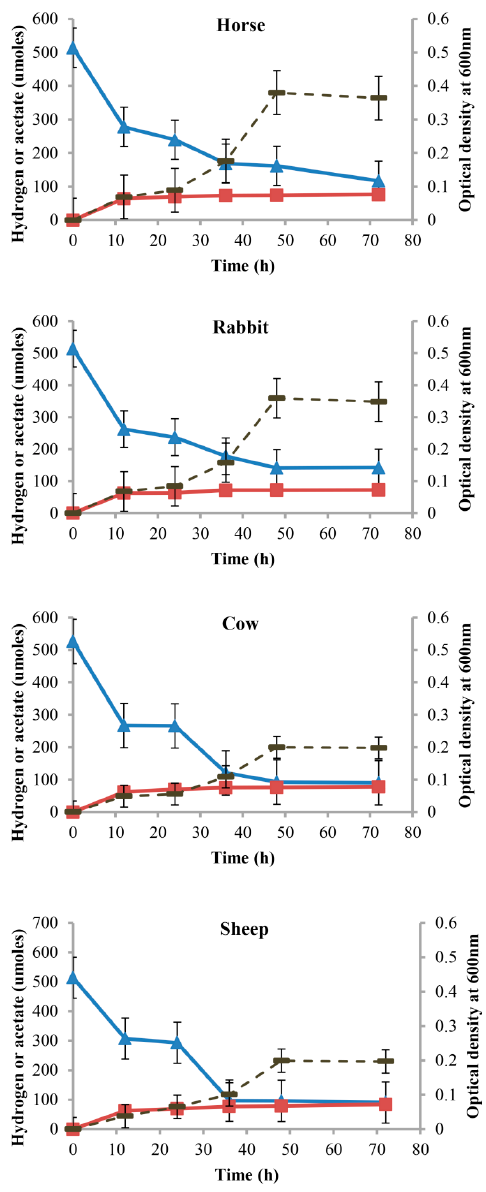
Figure 6. Acetate and hydrogen profiles of acetogen enrichment cultures from horse feces, rabbit cecum, and cow and sheep rumens under autotrophic conditions. Optical density (dashed line), acetate (squares), and hydrogen (triangles) profiles of acetogen enrichment cultures from horse feces, rabbit cecum, and cow and sheep rumens during growth on modified AC11.1 medium with only H 2 :CO 2 provided as substrates. Error bars represent standard error of mean.